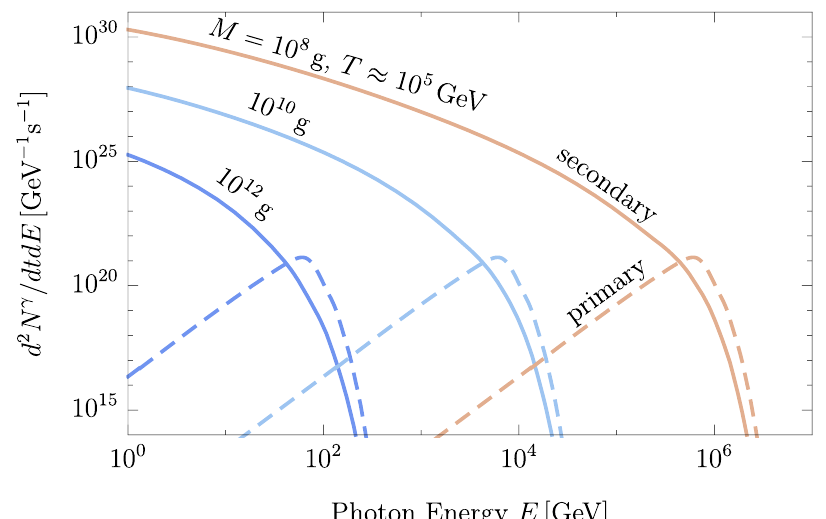
Figure 1: The primary (dashed) and secondary (solid) photon spectra at BH masses M = ( 10 12 ,10 10 ,10 8 ) g. In the SM, this corresponds to τ = ( 5 × 10 8 ,4 × 10 2 ,4 × 10 − 4 ) s where τ is the remaining lifetime of the